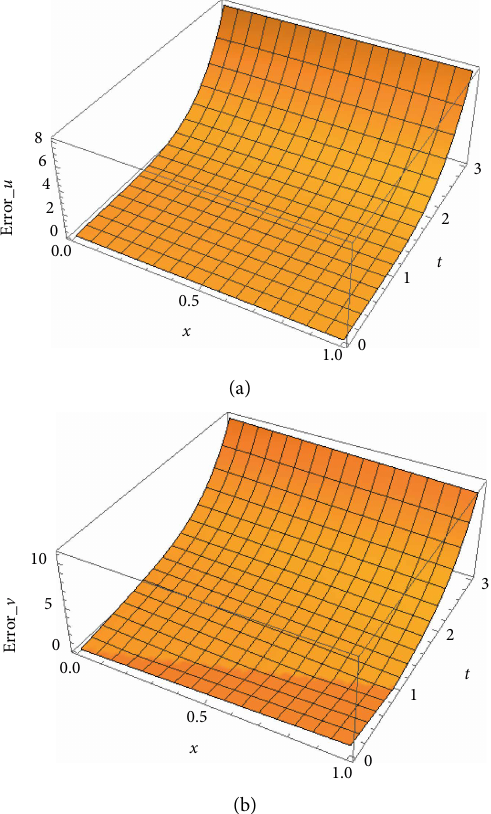
Figure 1: The figures explains the surface errors for Example (4.1).